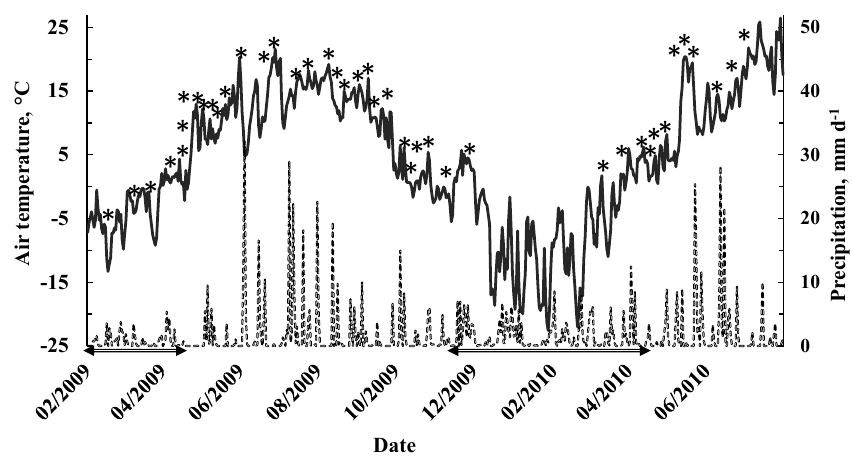
Figure 1. Daily mean air temperature (solid line) and daily precipitation (dashed line) at the sampling site during the sampling period from February 2009 to July 2010. Stars indicate the sampling dates (not all the trees were sampled every time). Horizontal arrows represent the snow cover periods.